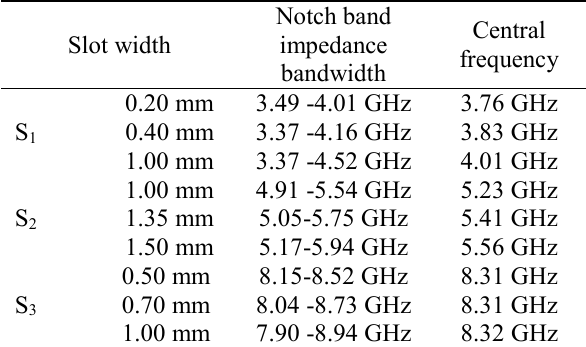
Figure 4: Simulated Reflection coefficient against frequency for proposed UWB antenna with various U slot widths (a) S 1 , (b) S 2 , (c) S 3 . Table 2: Parametric study of variation of different U- slots width (S 1 , S 2 , S 3